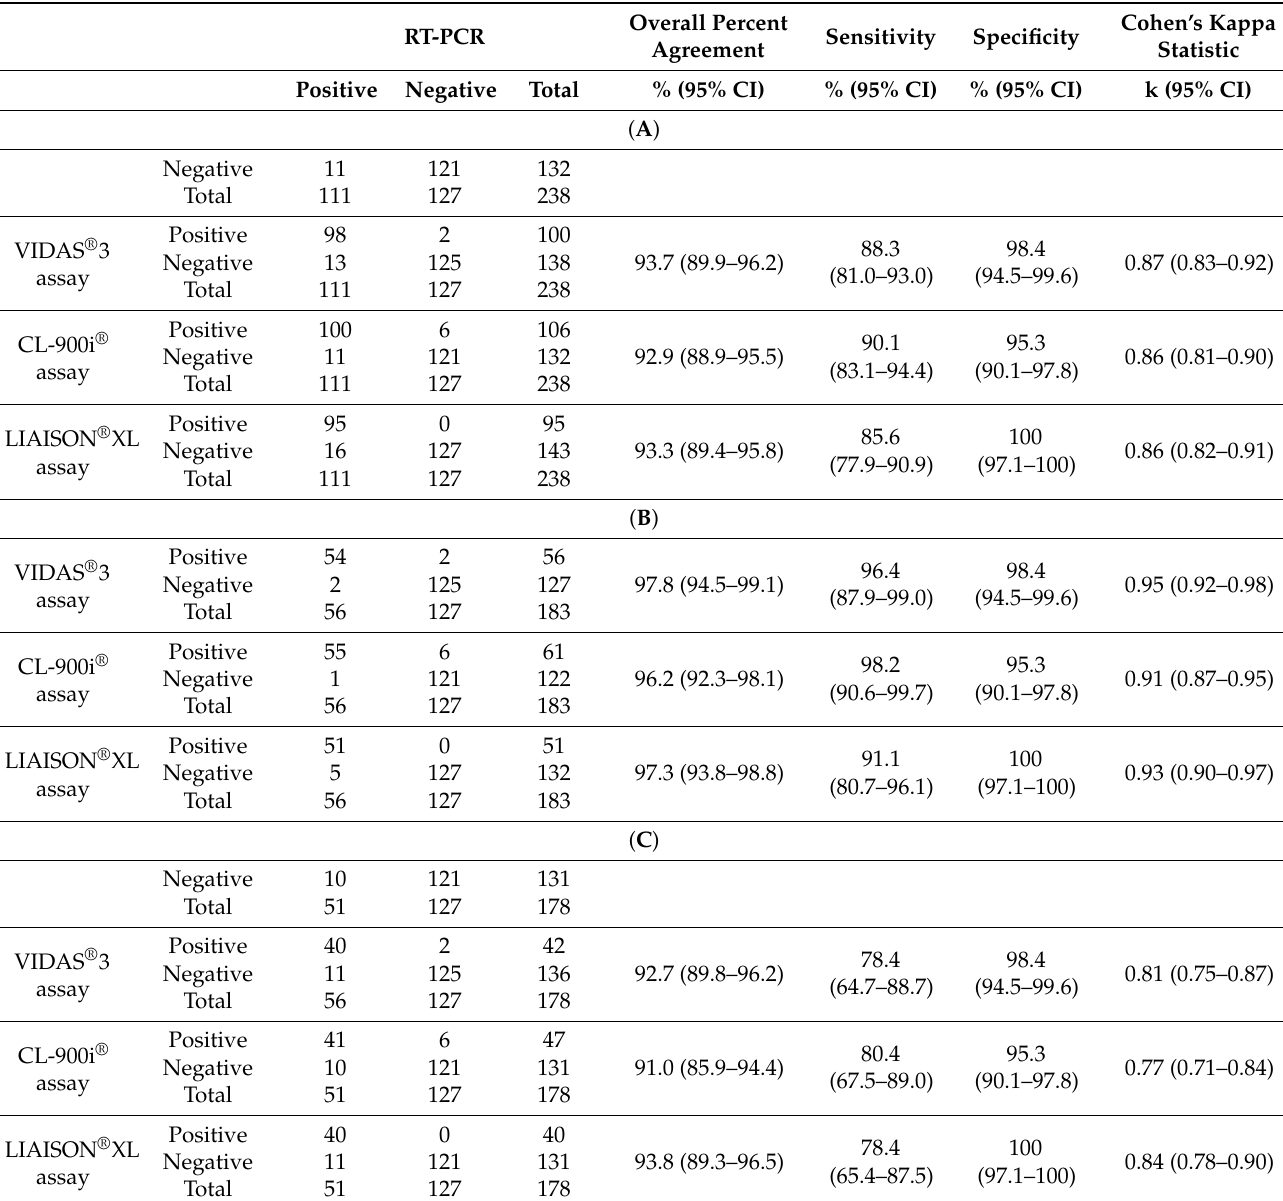
Table 2. Diagnostic assessment of the three automated analyzers for SARS-CoV-2 IgG detection using RT-PCR as a reference test for the ( A ) overall sample, ( B ) symptomatic patient group, and ( C ) asymptomatic patient